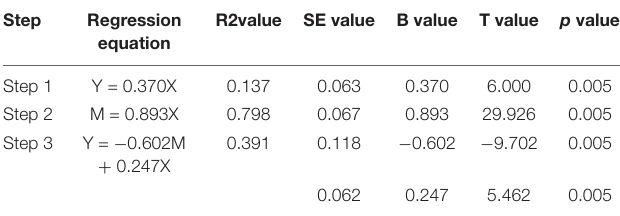
TABLE 11 | Analysis of the mediating effect of psychological capital on academic stress, and anxiety.